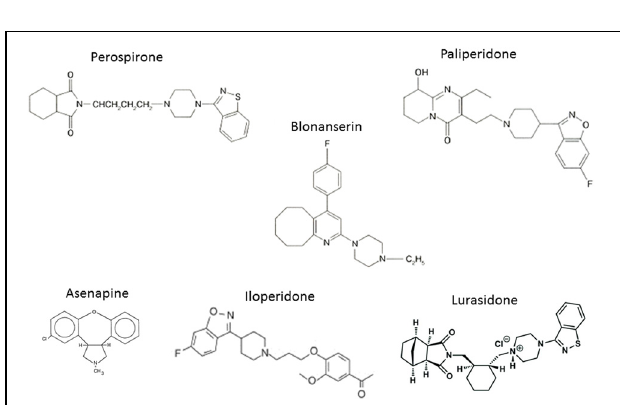
FIGURE 3 | Atypical (second generation) antipsychotic drugs widely used.